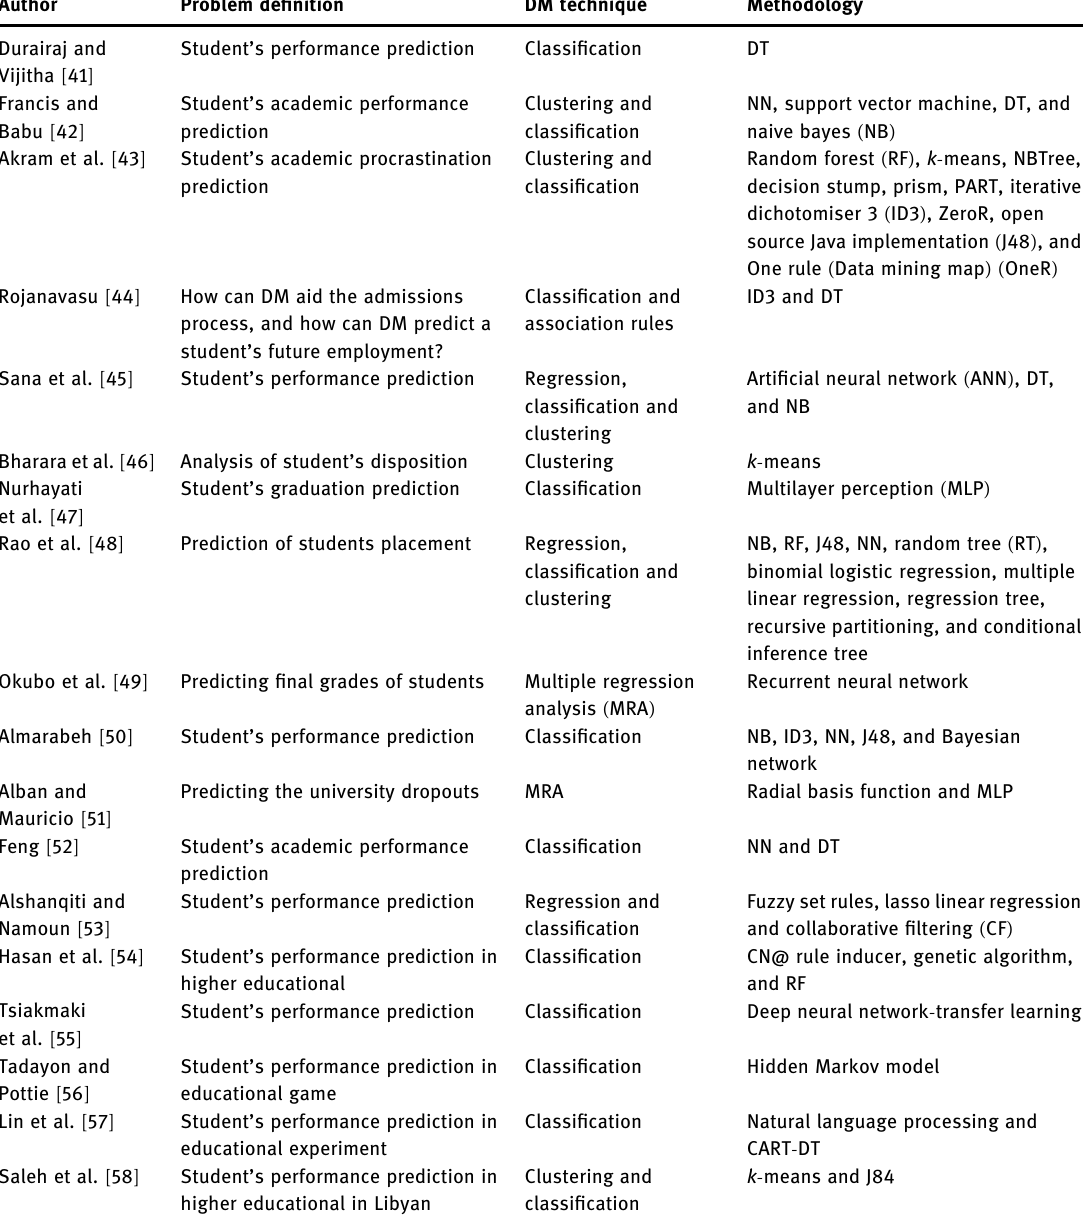
Table 1: Related studies on educational